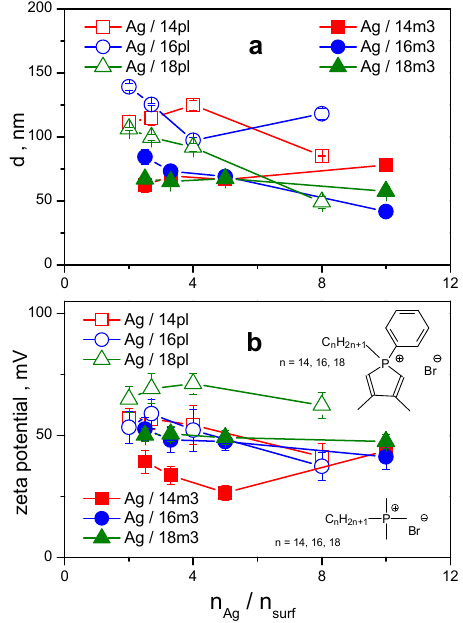
Figure 6. ( a ): Hydrodynamic size d of silver nanoparticles stabilized with heterocyclic alkylphenyldimethylphospholium surfactants 14pl , 16pl , 18pl , and non-heterocyclic alkyltrimethylphosphonium bromides 14m3 , 16m3 , 18m3 [52] plotted against n Ag /n surf . ( b ): zeta potential of AgNPs plotted against n Ag /n surf .